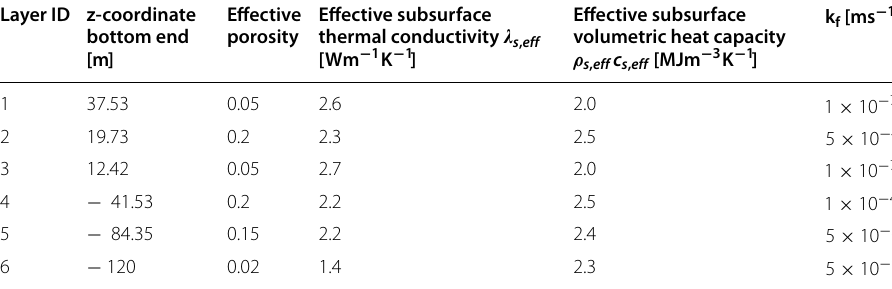
Table 3 Parameters in specific depths for BHE #2 exemplary Layer ID z‑coordinate bottom